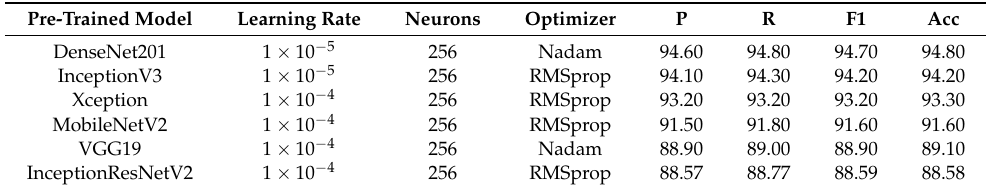
Figure 10. Confusion matrices of the models obtained from DenseNet201, Xception, MobileNetV2, Inception, VGG19 and InceptionResNetV2, by transfer learning. Multi-class classification with 0: Healthy, 1: Other, and 2: Rust. The darker the grid, the greater the number of cases located in that condition. Table 5. Performance metrics on test data of the best classification model for each architecture. P is precision, R is recall, F 1 is F1-score and acc is accuracy. Values are in percentages, with 100% being the best result and 0% being the worst performance result.